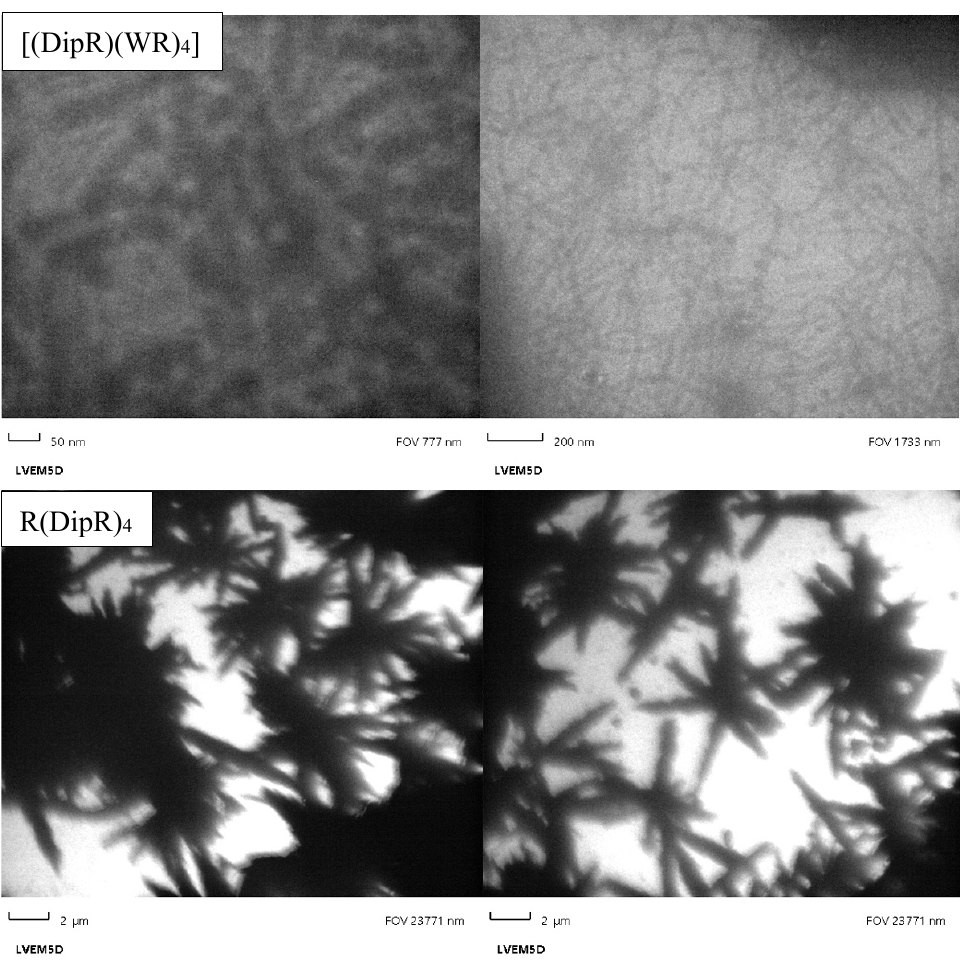
Figure 12. [DipR] 5